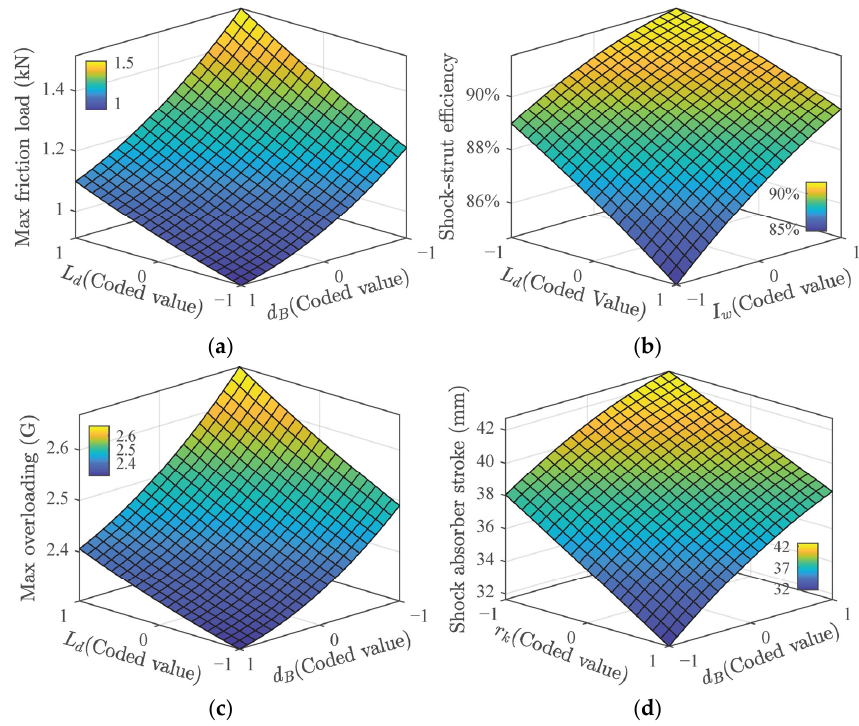
Figure 11. The top two sensitive variables influence on the four landing responses: ( a ) Max load of strut friction; ( b ) Shock-strut efficiency; ( c ) Max overloading of the sprung mass; ( d ) Shock absorber stroke.